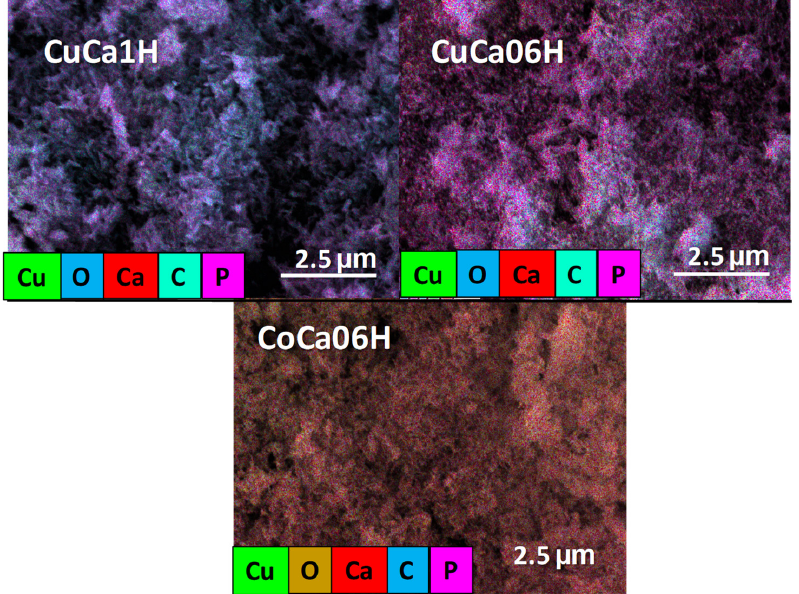
Figure 10. EDS elemental mappings of the spent CuCa1H and CuCa06H (after the 5th cycle), and CoCa1H (after the 3rd cycle). Reaction conditions: 75 mg of catalyst, glycerol to acetic acid molar ratio of 0.25, and reaction temperature of 80 °C.